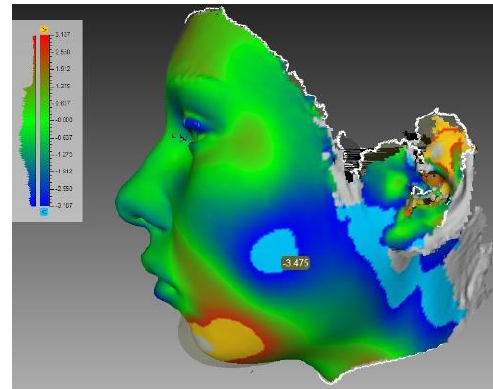
Figure 5. Pressing test. The protrusion over the zygomatic arch. Computed tomography reconstructions demonstrates the connection between the temporal and cheek areas by the BFP. The temporal, infraorbital, pterygopalatine processes of buccal fat pad connect the deep areas of face with the superficially lying cheek area, so the septic process can spread along this fatty tract and involve the structures as the nerves, venous plexuses, arteries and can spread on the other adjacent structures.